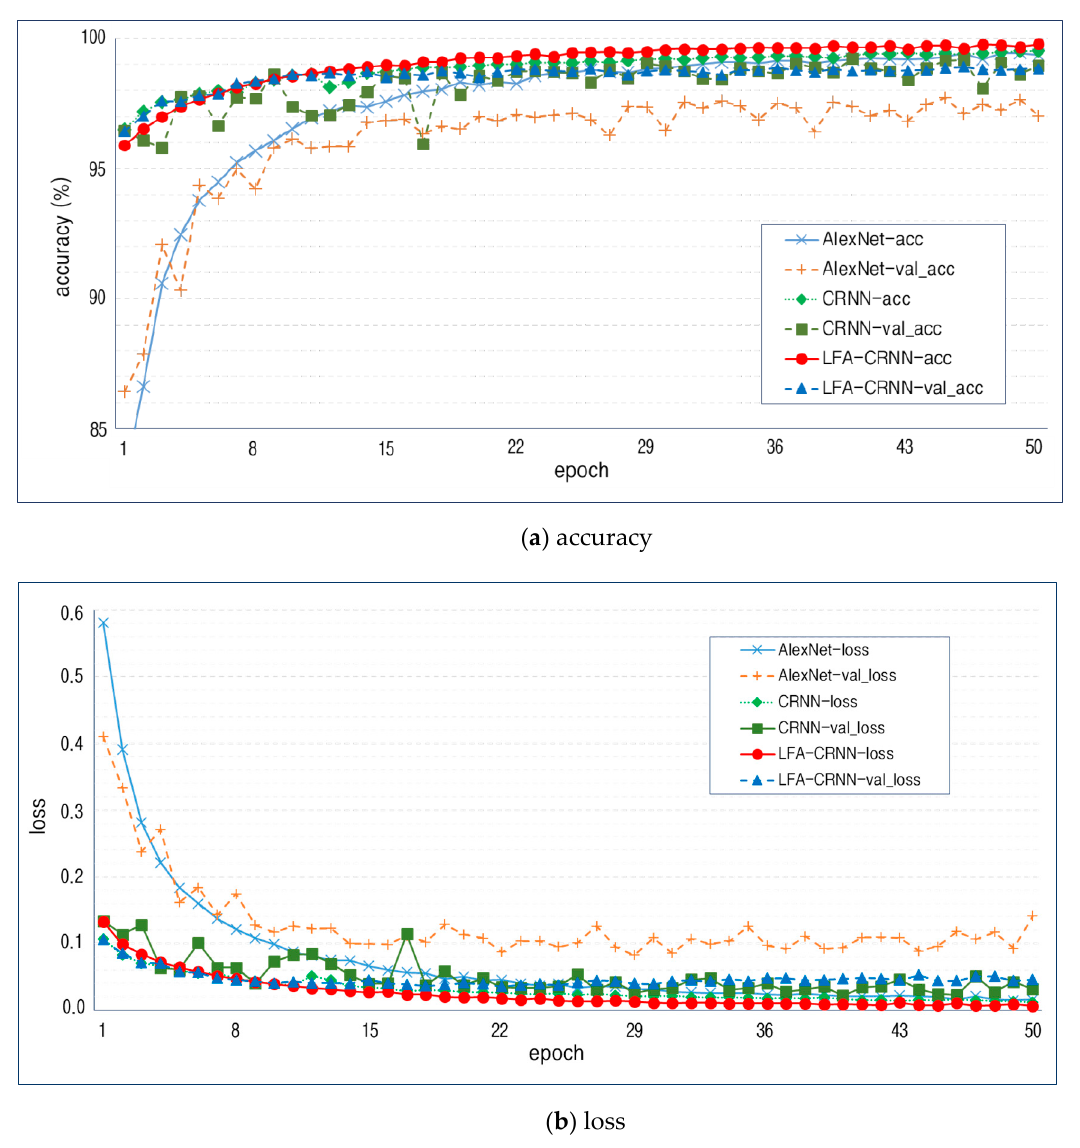
Figure 10. Accuracy and loss measurement results using the University of Northern British Columbia (UNBC)-McMaster shoulder pain expression database.